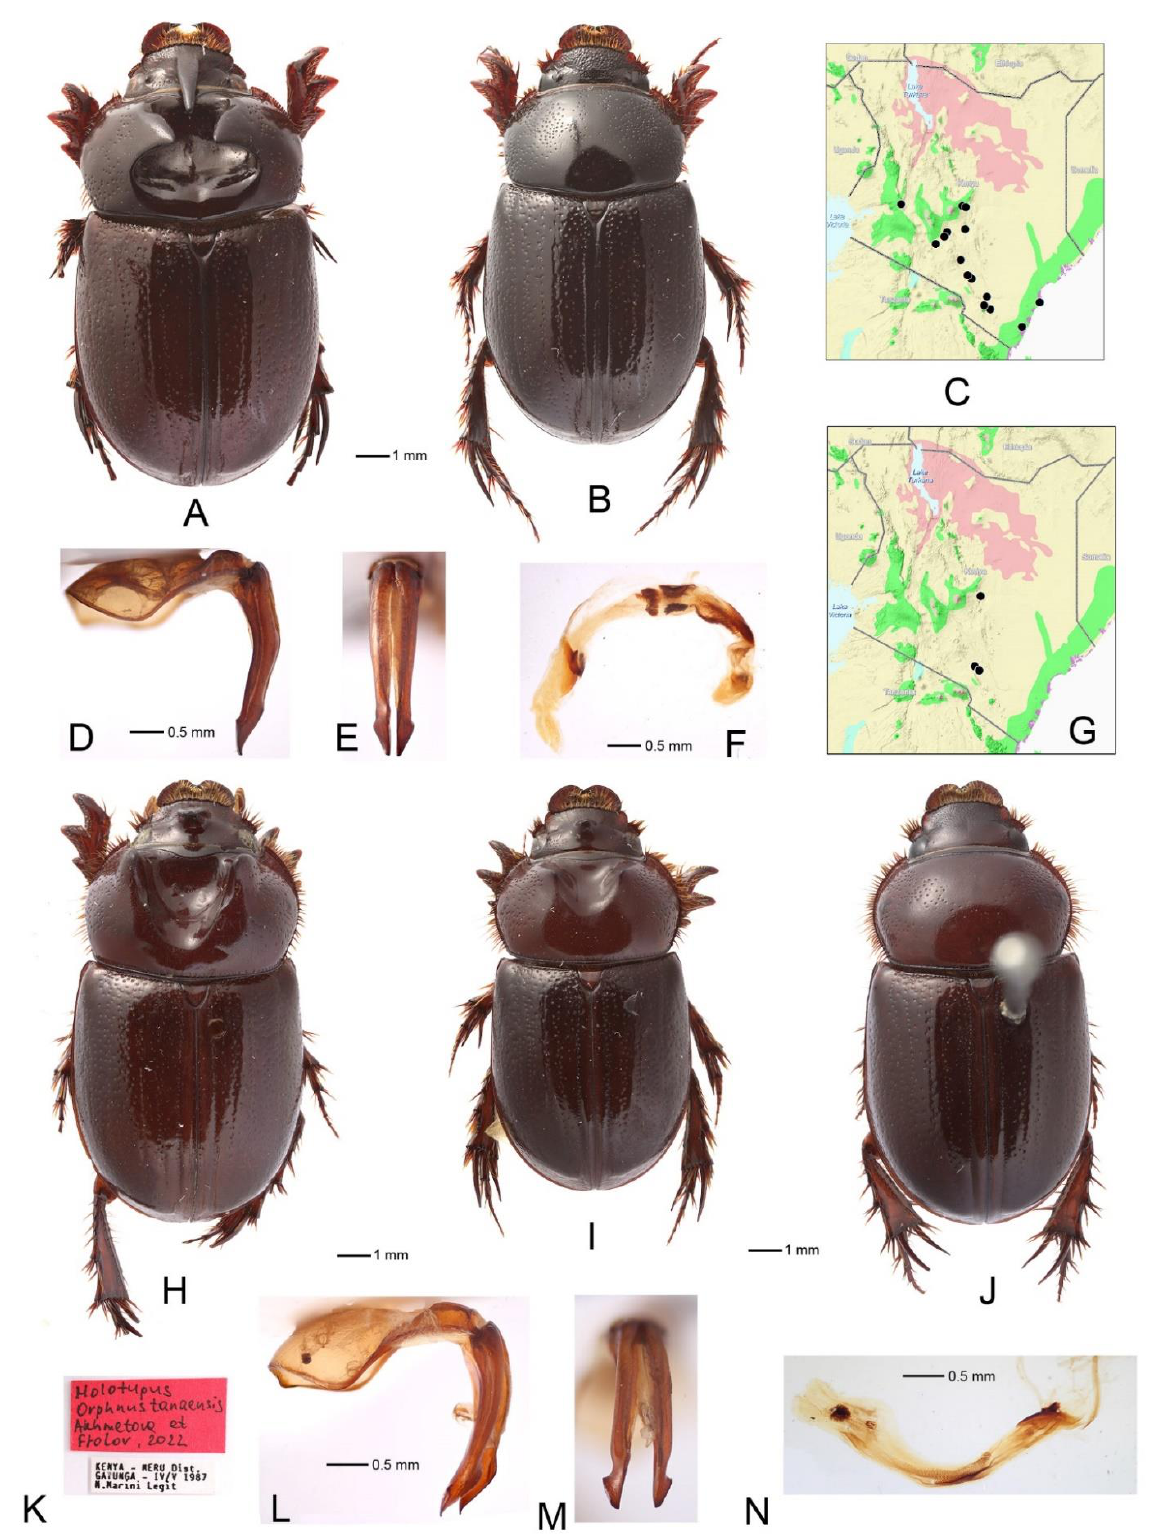
Figure 5. Orphnus sansibaricus Kolbe, 1895 ( A – F ) and O. tanaensis Akhmetova et Frolov, sp. nov. ( G – N, ( H , K – N, holotype)). ( A , H , I ) male, habitus; ( B , J ) female, habitus; ( D , L ) aedeagus in lateral view; ( E , M ) parameres in dorsal view; ( F , N ) endophallus; ( K ) labels; ( C , G ) distributional record map.